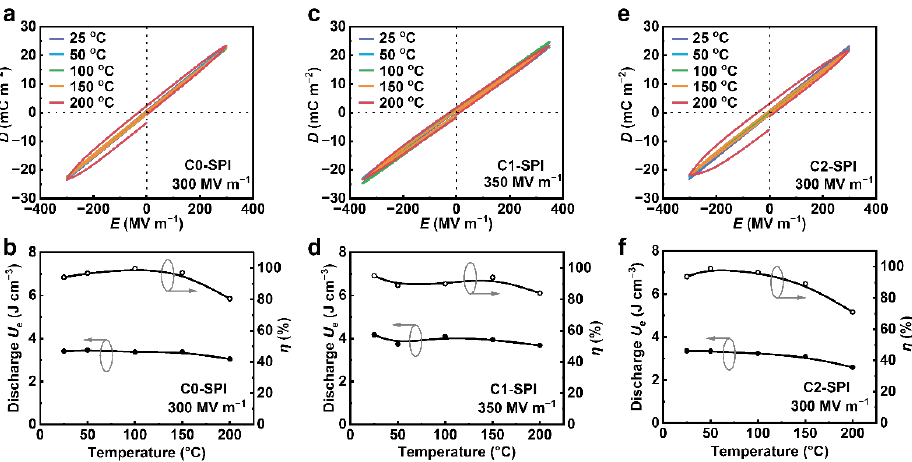
Figure 6. Bipolar D – E loops at different temperatures of ( a ) C0-SPI at 300 MV m −1 , ( c ) C1-SPI at 350 MV ∙ m −1 , and ( e ) C2-SPI at 300 MV ∙ m −1 , and corresponding discharged energy density ( U e ) and charge – discharge efficiencies ( η ) as a function of temperature ( b , d , f ).